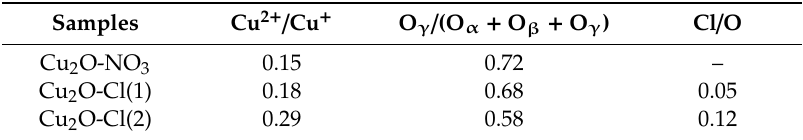
Figure 5. X-ray photoelectron spectroscopy (XPS) spectra of the three samples: ( A ) full survey spectrum, ( B ) Cu2p, and ( C ) O1s. ( a ) Cu 2 O-NO 3 ; ( b ) Cu 2 O-Cl(1); and ( c ) Cu 2 O-Cl(2). Table 2. The X-ray photoelectron spectroscopy (XPS) a analysis of surface chemical composition of the three samples.